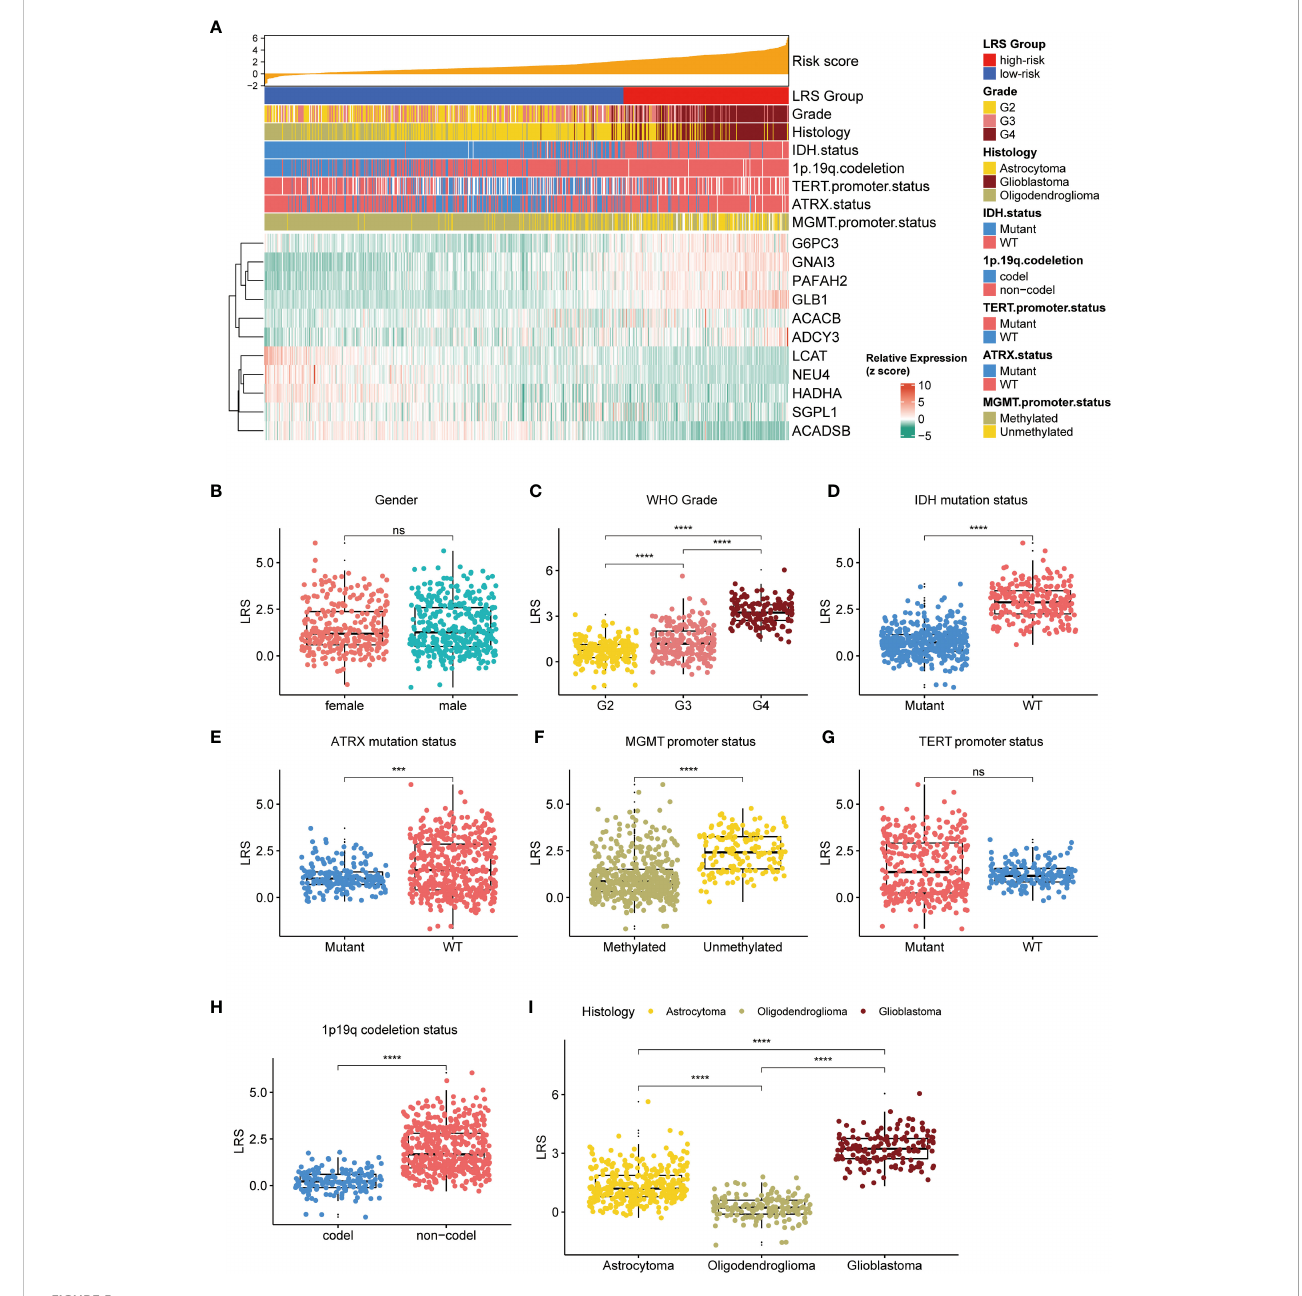
FIGURE 5 Relationship between LRS and clinicopathological variables. (A) , waterfall plot depicted relationship between LRS, 11prgnostic LMRGs and clinicopathological variables; Relationship between LRS and clinicopathological variables including gender (B) , WHO grade (C) , IDH mutation status (D) , ATRX mutation status (E) , MGMT promoter status (F) , TERT promoter status (G) , 1p19q codeletion status (H) , and histology (I) . LRS, lipid metabolism risk score; LMRG, lipid metabolism-related gene. ns, non-signi fi cant. *** p<0.001, **** p<0.0001 in the current